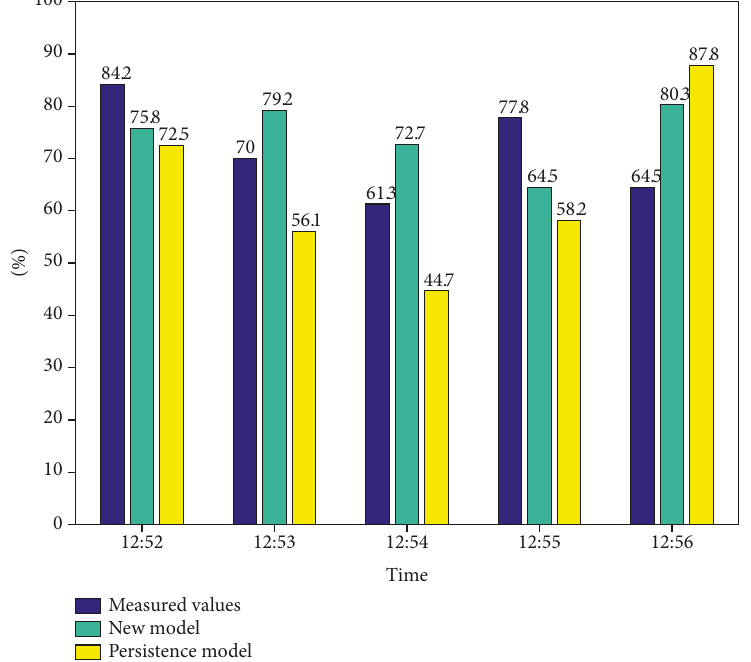
Figure 5: Comparison between the measured and simulated cloud cover on 22nd June 2014 from 12:52 until